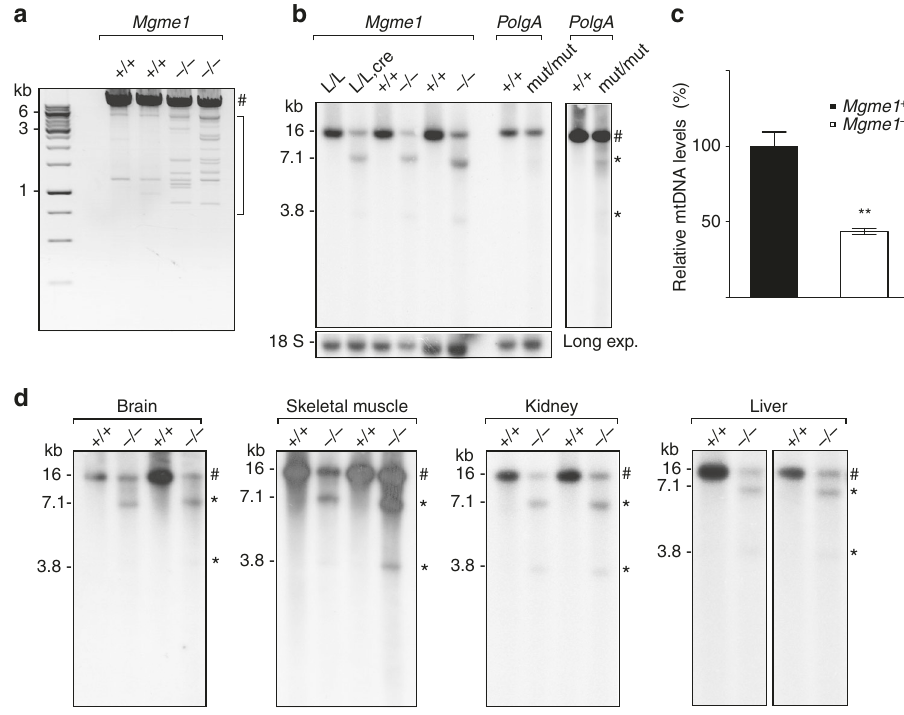
Fig. 2 MtDNA depletion and accumulation of deletions in Mgme1 homozygous and tissue-speci fi c knockout mice in various tissues. a Long-extension PCR of heart-isolated total DNA from 8 weeks old controls ( + / + ) and Mgme1 knockout mice ( − / − ) using primers amplifying major arc. # indicates product form full-length mtDNA, parentheses indicate deleted products. The bands are visualized by EtBr staining. b Southern blot analysis of SacI-digested heart mtDNA from control ( Mgme1 L/L ) and tissue-speci fi c knockout mice ( Mgme1 L/L , cre ), wild-type ( Mgme1 + / + ) and Mgme1 knockout mice ( Mgme1 − / − ) and control ( PolgA + / + ) and mtDNA-mutator mice ( PolgA mut/mut ). Plasmid pAM1, containing whole mtDNA sequence was used as a probe. # full-length mtDNA; *deleted mtDNA molecules. c Southern blot quanti fi cation: ratio of full-length mtDNA signal to 18S loading control. Error bars represent the SEM. **P < 0,001, Statistical analysis were performed using Student ’ s t -test. n = 3 biological replicates. d Southern blot analysis of SacI-digested mtDNA from brain, skeletal muscle, kidney, and liver tissue. ( + / + ), control; ( − / − ), Mgme1 knockout mice. Plasmid containing whole mtDNA sequence was used as a probe. # full-length mtDNA; *deleted mtDNA